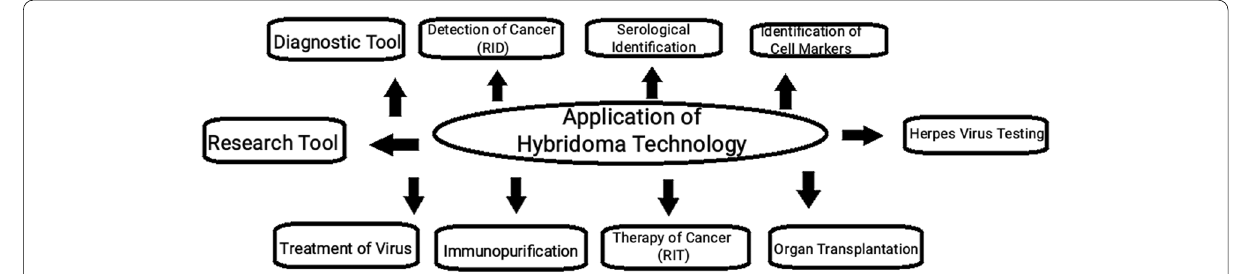
Fig. 5 Application of hybridoma